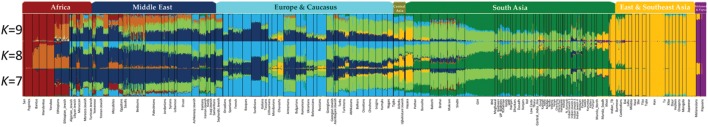
Admixture analysis of worldwide populations. Admixture analysis was performed for K = 7–9. The x-axis represents individuals from populations sorted according to their reported ancestries. Each individual is represented by a vertical stacked column of color-coded admixture proportions that reflects genetic contributions from putative ancestral populations. Indian Jews are underlined. The authors considered the dark blue component visible K = 7 as a representative of a “Middle East Ancestry.” Modified from Chaubey et al. (2016).